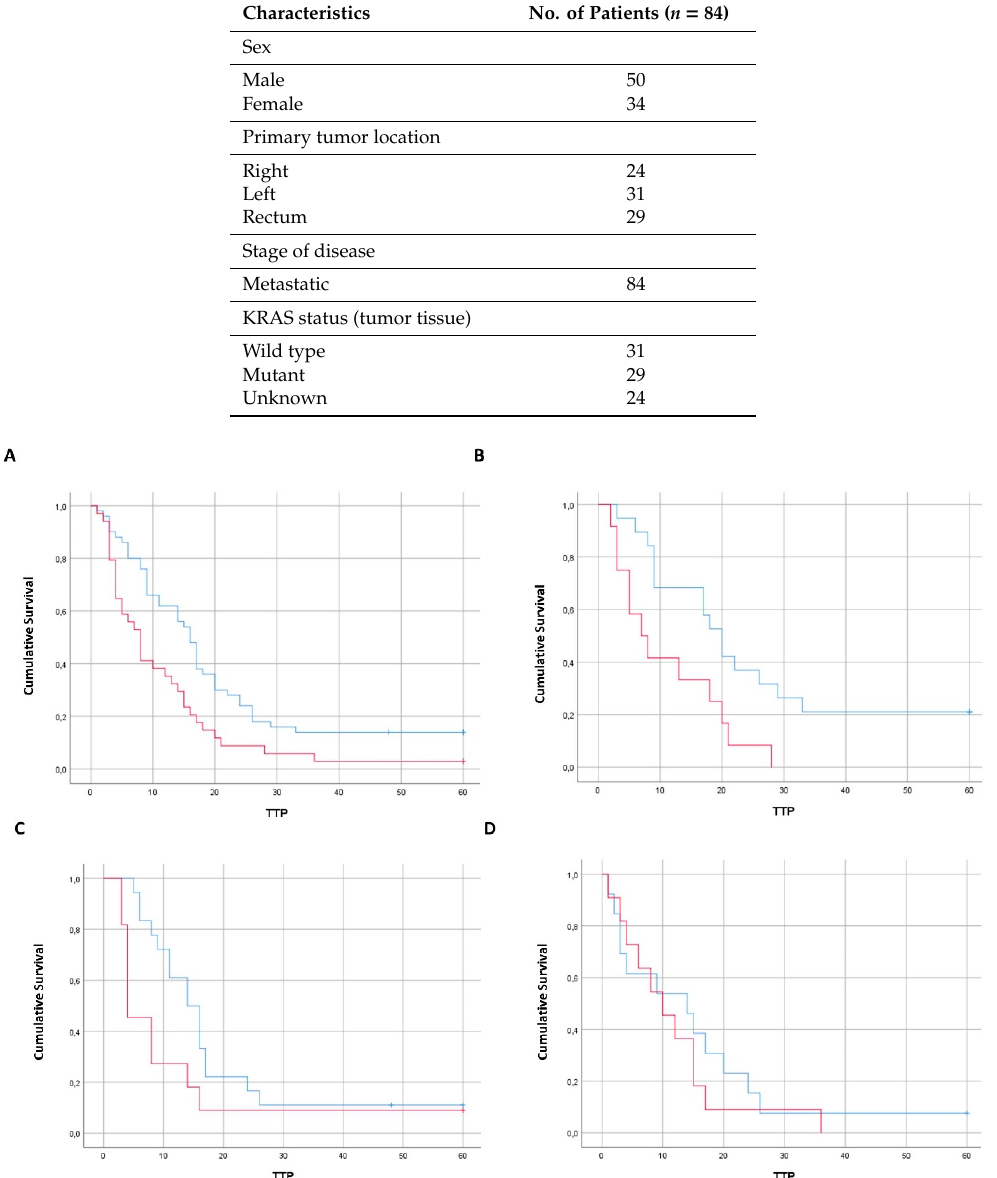
Figure 1. Prognostic impact of CTC on time to progression (TTP). Panel A : Comparison in TTP between CTC-positive vs. CTC-negative samples (all mCRC pts). Panel B : Comparison in TTP